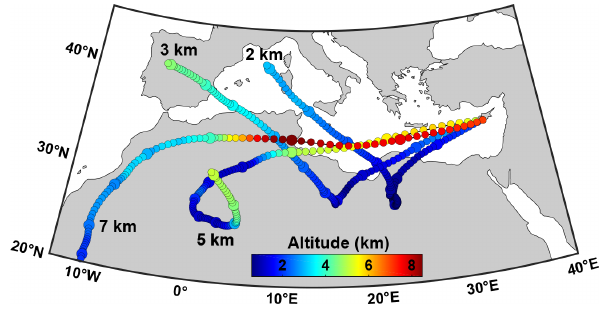
Figure 4. The 120h HYSPLIT backward trajectories starting over Limassol at 01:00UTC on 21 April 2017. Colour coding refers to the height of the trajectories. Intervals of 12h are marked by in- creased circle size. The numbers in the plot refer to the arrival height over Limassol.